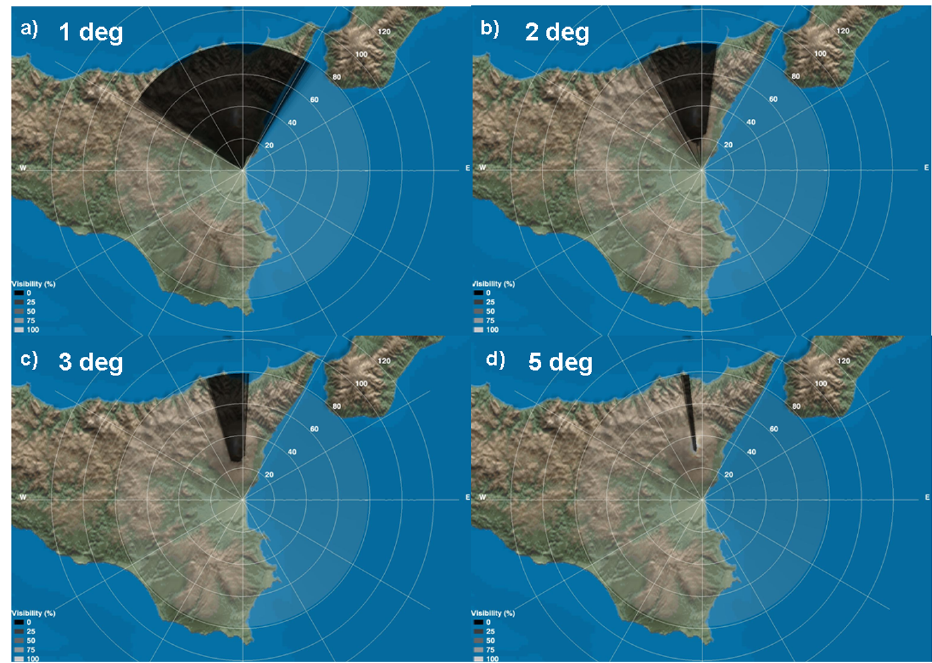
Figure 1. Visibility maps for the considered radar system as retrieved using a 250m digital terrain model (DTM) at 1, 2, 3 and 5 ◦ of antenna